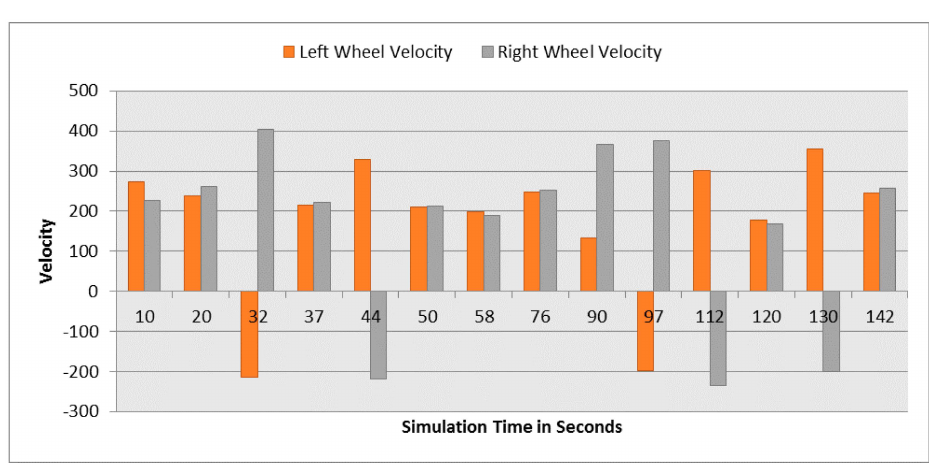
Figure 22. Left and right wheel velocities at different simulation